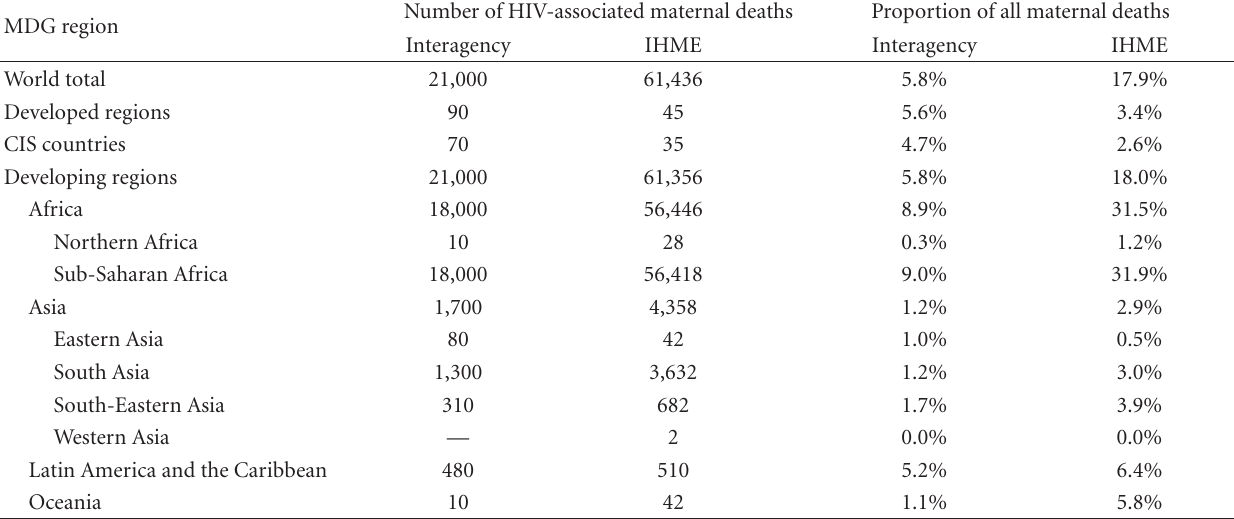
Table 1: HIV-associated maternal deaths by region, 2008, by model.